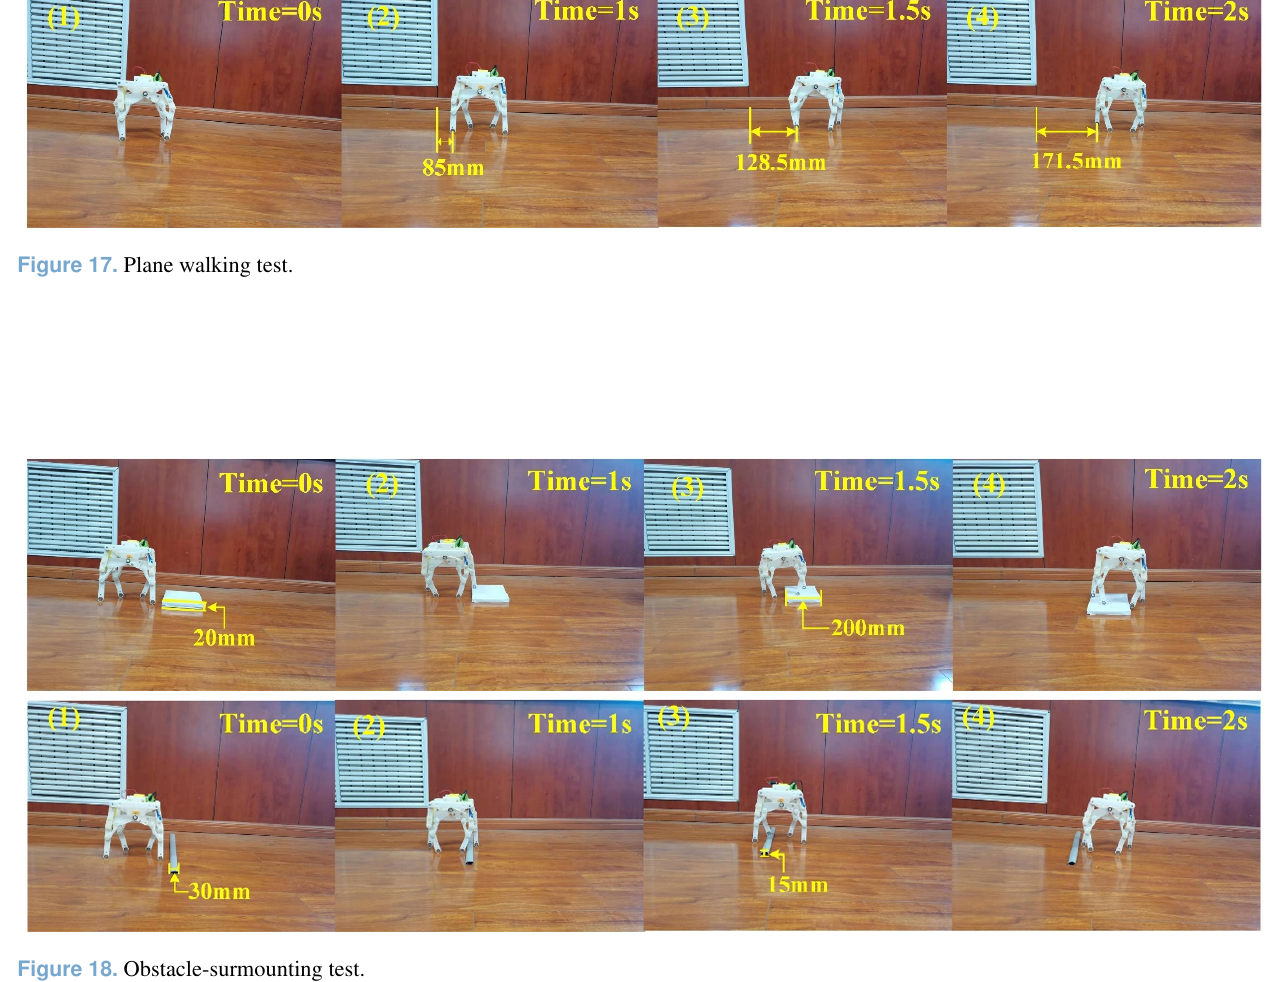
Figure 18. Obstacle-surmounting test.